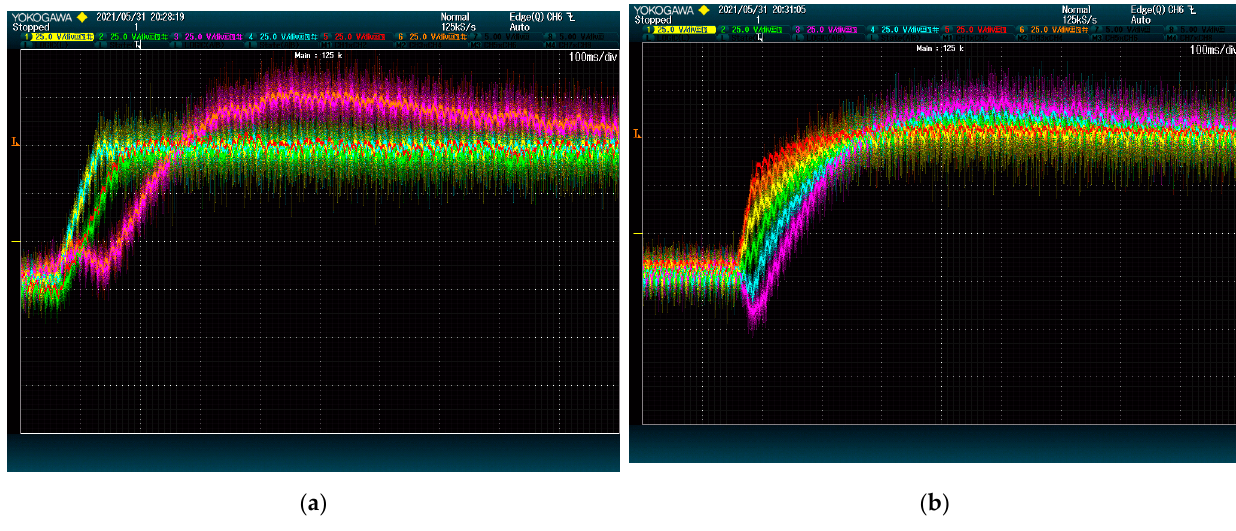
Figure 10. DC-Link voltage dynamics upon a reference step with different voltage gains: ( a ) gain by phase; ( b ) gain by module. The plots show voltage (25 V/div) vs. time (50